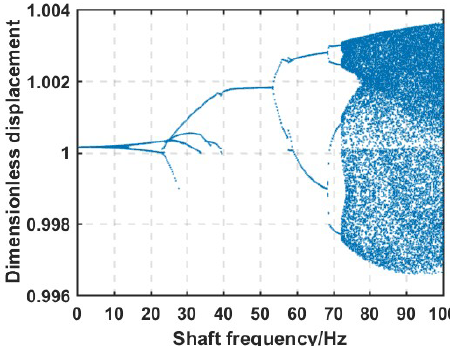
Figure 6. Bifurcation diagram normal conditions.